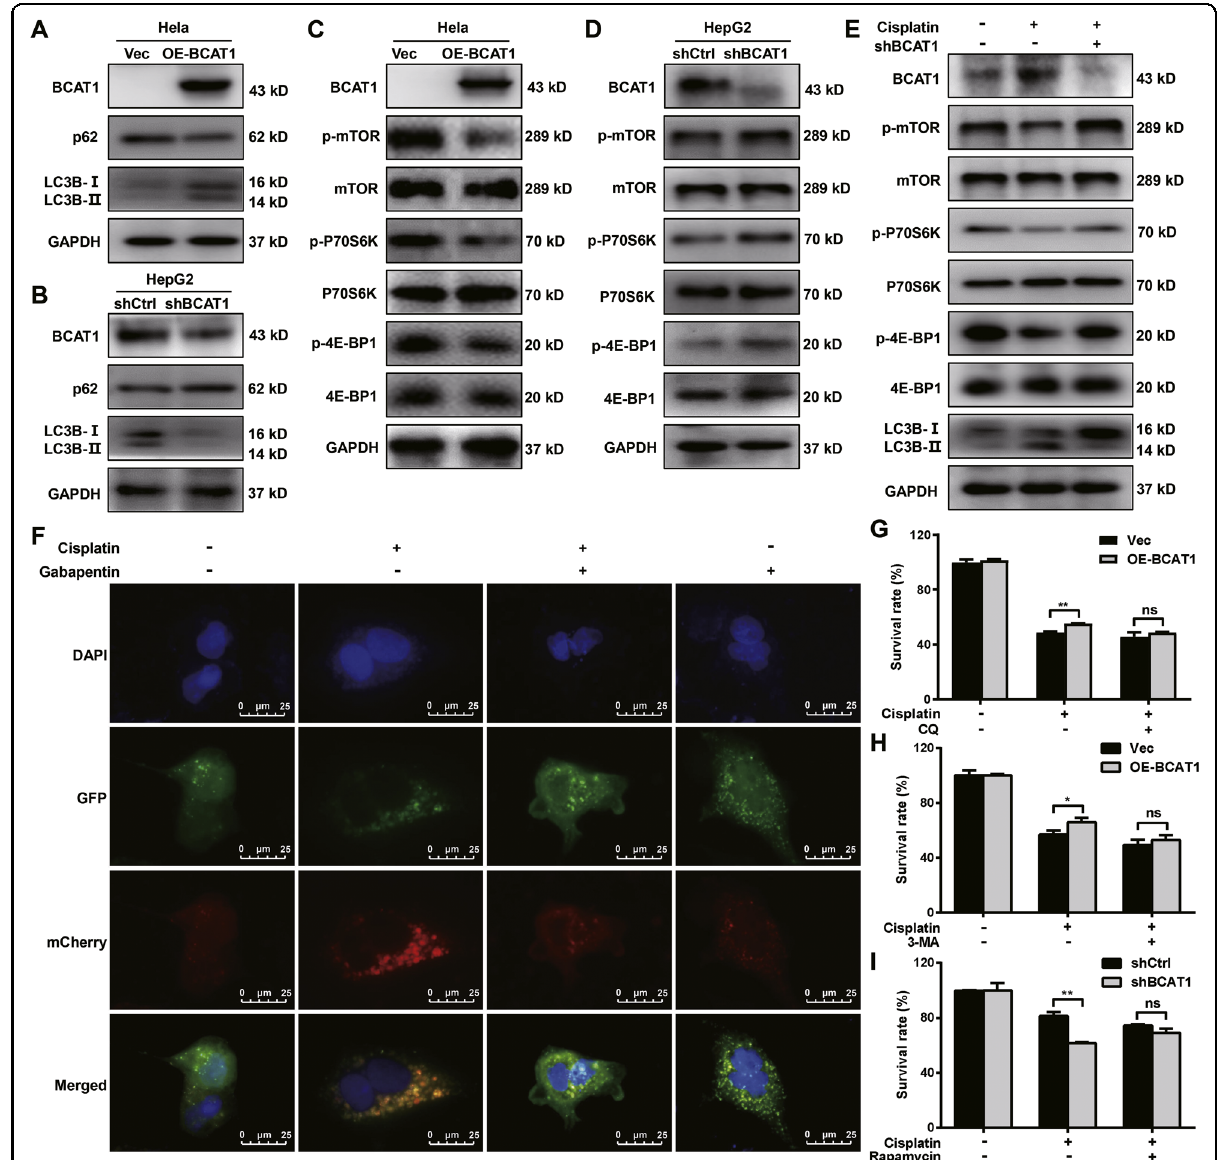
levels of BCAT1, mTOR, p70S6K, and 4E-BP1 and their phosphorylated counterparts in Hela cells overexpressing BCAT1. D The protein levels of BCAT1, mTOR, p70S6K, 4E-BP1 and their phosphorylated counterparts in BCAT1 knockdown HepG2 cells. E The protein levels of BCAT1, mTOR, p70S6K, 4E- BP1 and their phosphorylated counterparts and LC3-I/II in HepG2 or BCAT1 knockdown HepG2 cells treated with cisplatin (10 μ M). F Representative image of HepG2 cells transfected with pCMV-mCherry-GFP-LC3B. The cells were treated with cisplatin (10 μ M) or gabapentin (5 mM) alone or together for 24 h. Scale bars: 25 μ m. G , H Hela cells overexpressing BCAT1 were treated with cisplatin (20 μ M) alone or in combination with 20 μ M CQ or 2 mM 3-MA for 24 h. Cell viability was assessed by CCK-8 assays. (I) BCAT1 knockdown HepG2 cells were treated with cisplatin (10 μ M) alone or plus with rapamycin (100nM) for 24 h. Cell viability was assessed by CCK-8 assays. Vec, empty vector; Ctrl, control. Three independent experiments were performed. ns, not signi fi cant. * P < 0.05, ** P <